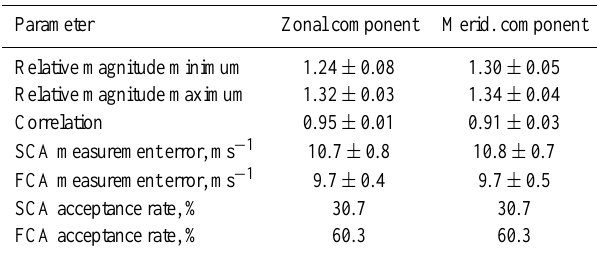
Table 5. Mean and standard deviation of daily relative magnitude minima and maxima, correlation, maximum measurement errors, and acceptance rates for SCA relative to FCA-small from 18 Octo- ber 1996 to 1 May 1997.